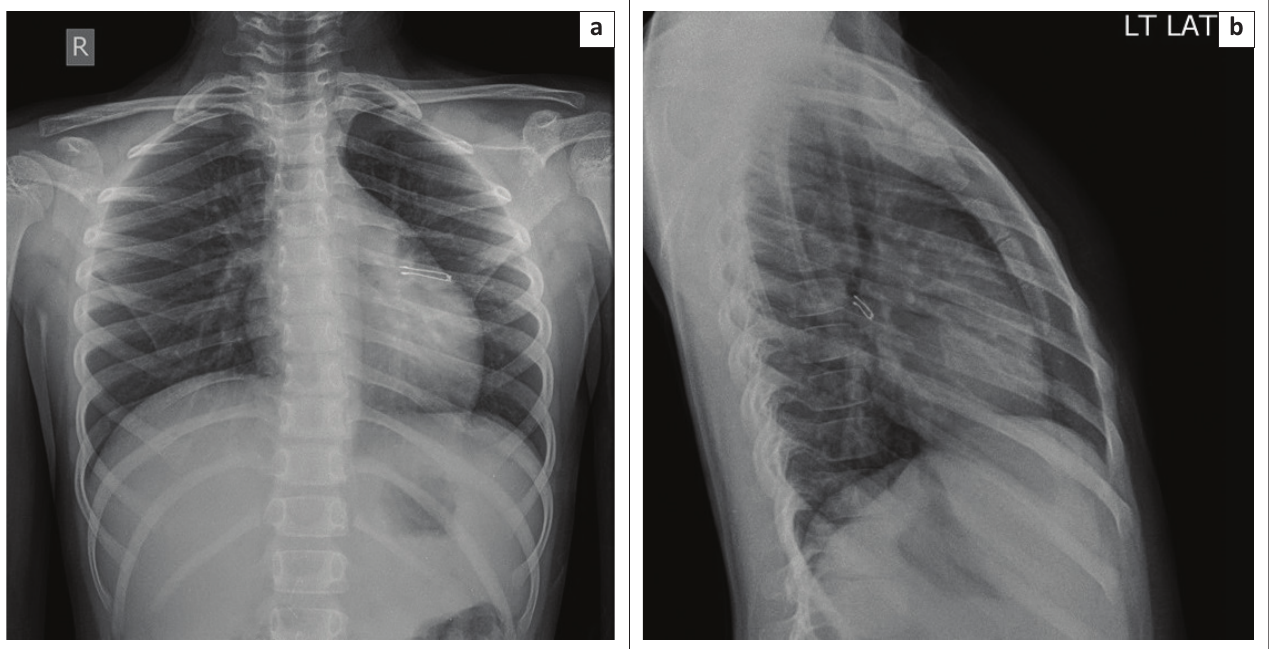
FIGURE 11: Frontal (a) and lateral (b) radiographs in a 3-year-old child who aspirated a light emitting diode bulb into the left main stem bronchus.